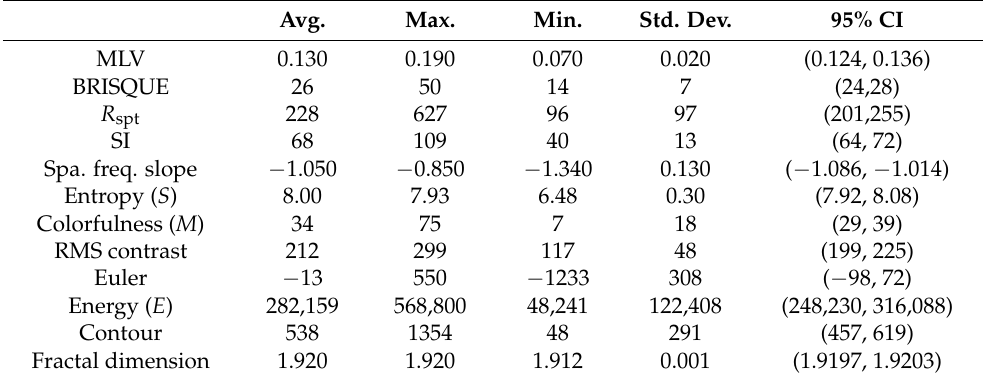
Table 1. Summary of the image quality metrics for 50 images used in the experiment.